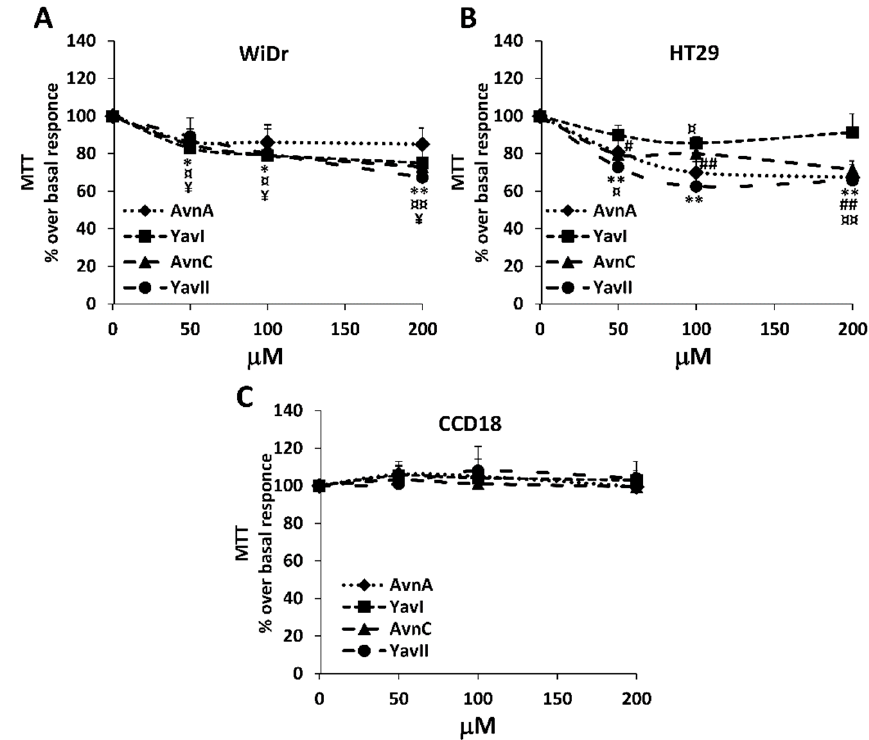
Figure 2. Effects of natural and yeast derived avenanthramides on cancer cell viability. Cells viability was evaluated by the MTT assay. Cells were exposed to increasing concentration of Avns and YAvns (50, 100 and 200 µM) for 3 days. Data are expressed as percentage over basal control. Statistical analysis: AvnA: ## p < 0.01 and # p < 0.05; YavI: ¥ p < 0.05; AvnC: ¤¤ p < 0.01 and ¤ p < 0.05; YavII: ** p < 0.01 and * p < 0.05 vs. basal control.